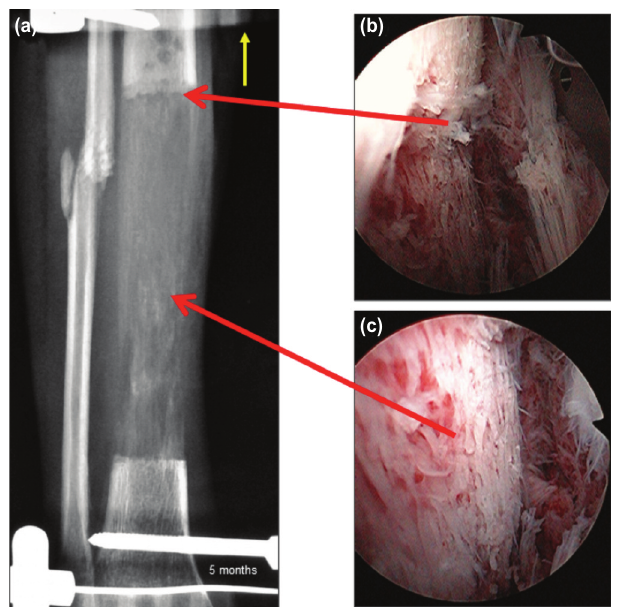
(a) Bone transport at five months showing distraction Fig. 2: osteogenesis over the distal half of the right tibia, lower horizontal Schanz screw inserted just above the ankle joint with yellow arrow indicating the direction of bone transport from the ankle corticotomy site; (b) Endoscopic view from the posterior aspect of the tibia following soft tissue release with red arrow at the junction of the corticotomy and the edge of bone regeneration; and (c) Endoscopic view from the posterior aspect of the regenerating bone with red arrow at the middle section of the distraction osteogenesis showing spongy nature of the regenerated bone.